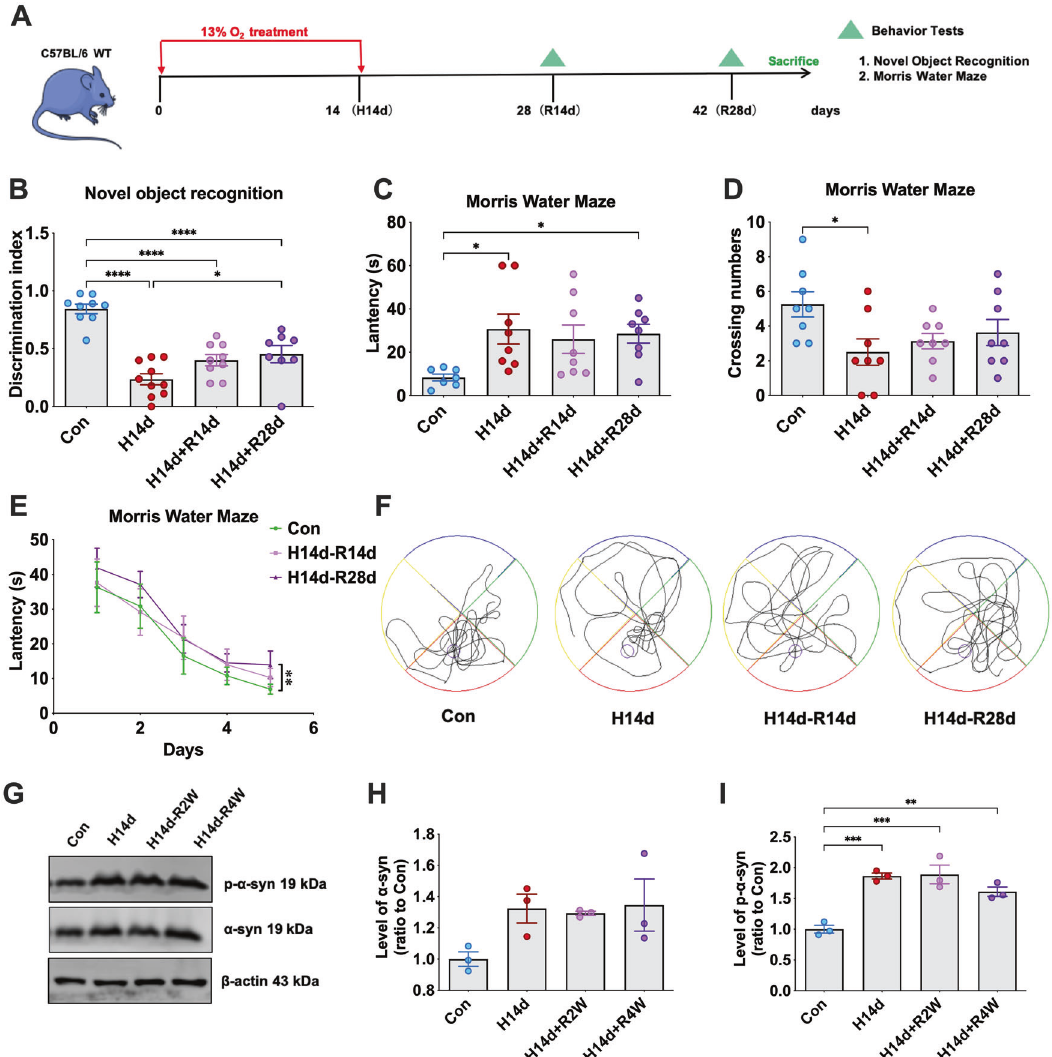
then underwent behavioral tests at different time points. B Detection and statistical analysis of the novel object recognition tests in mice of each group. C – F Detection and statistical analysis of the Morris water maze tests in mice of each group. G – I The levels of p- α -syn and α -syn in the hippocampi of mice in the Con, H14d, H14d + R2W, and H14d + R4W groups were detected by western blots with β -actin as the internal reference; statistical analysis was performed. Data are expressed as the mean ± SEM (one-way ANOVA), * P < 0.05, ** P < 0.01, *** P < 0.001, **** P < 0.0001, n = 10 in B – E , n = 3 in G – I